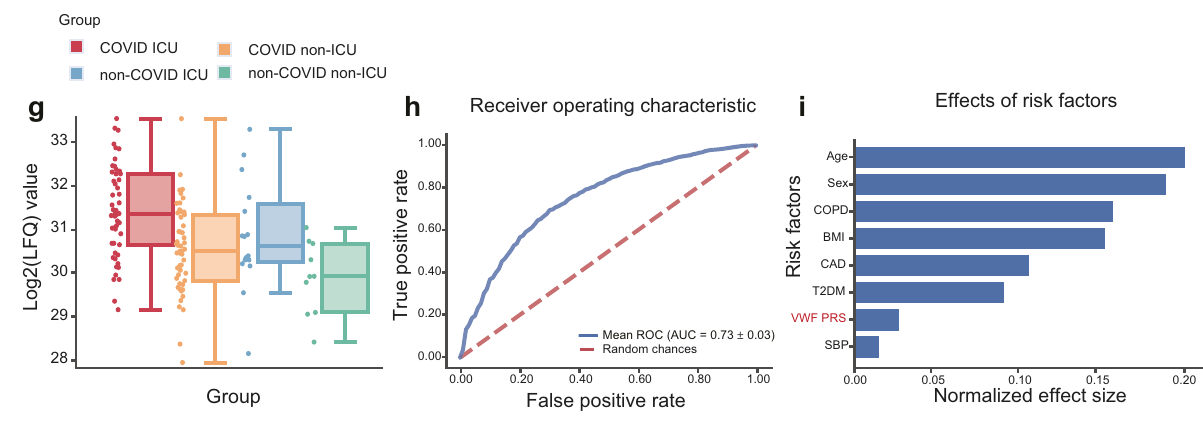
disease (COPD) 5 . By evaluating the association of the VWF PRS and COVID-19 severity risk using a logistic regression model adjusted for the top 10 principal components of genetic variations and other selected risk factors (age, sex, BMI, CAD, SBP, T2DM, and COPD), we found that PRS of VWF is an independent risk factor for distinguishing severe COVID-19 cases from healthy controls, which explains a 16% higher risk ( P = 0.011, OR per SD increase = 1.16, 95% CI: 1.03 – 1.29).